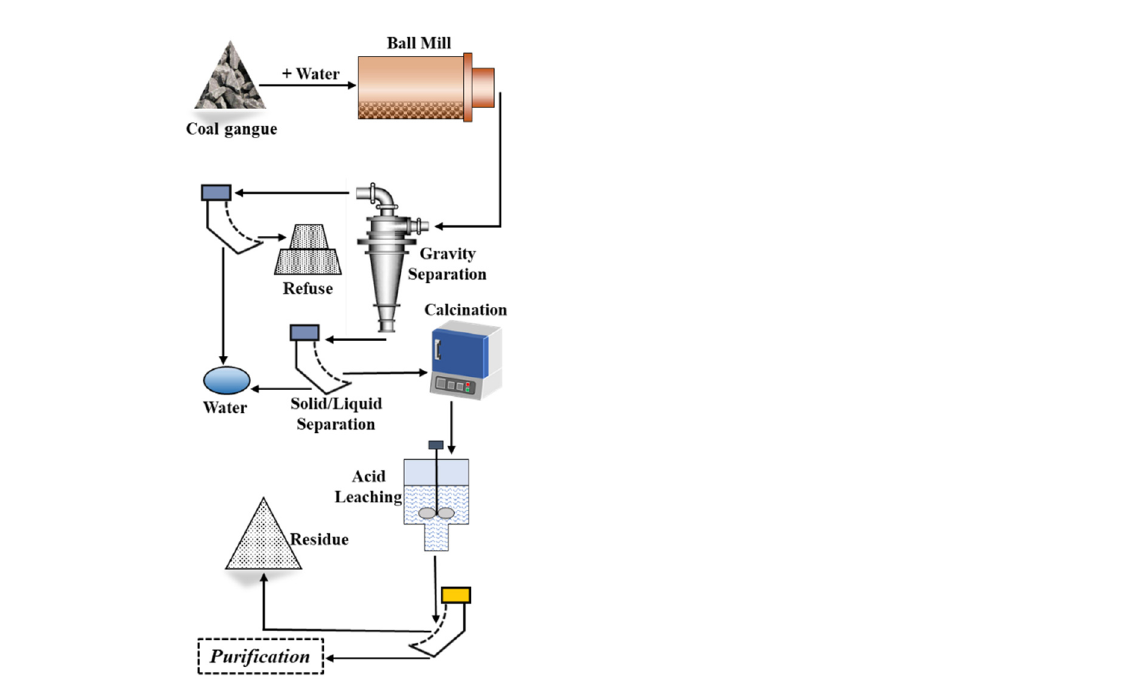
Figure 11. The combined flowsheet for co-extraction of Li and Ga from coal gangue.